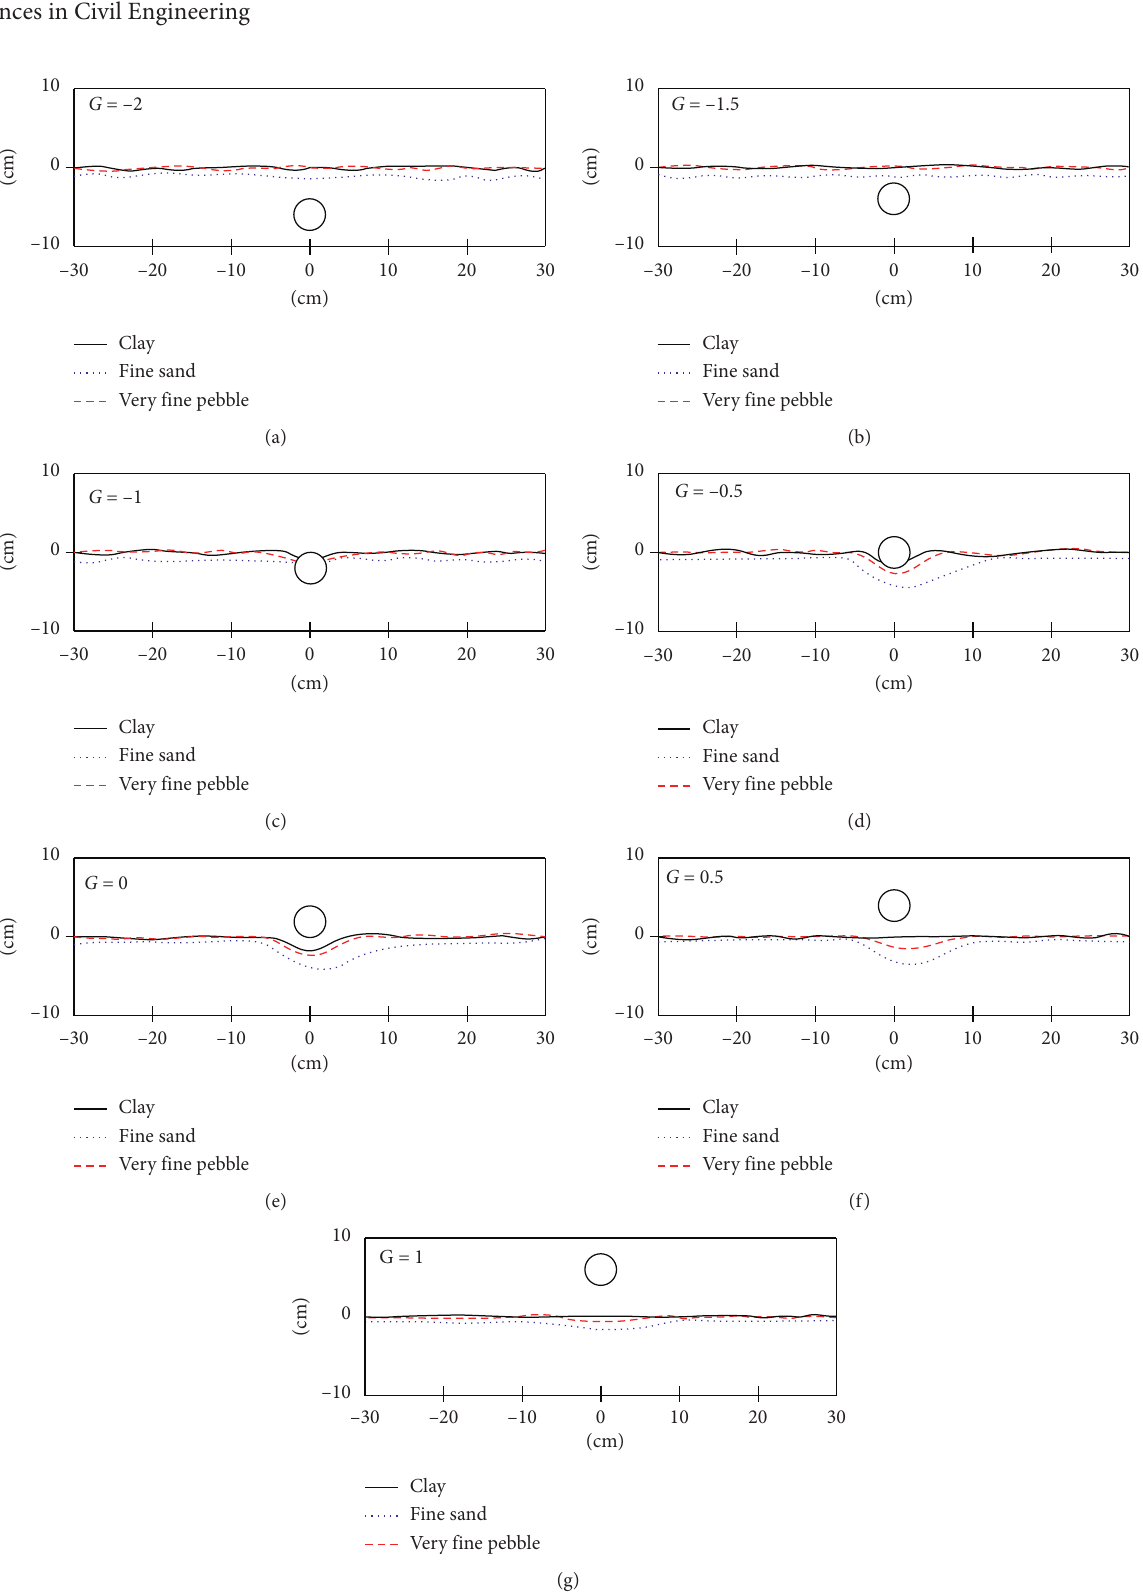
Figure 9: Scour profile under different embedment ratios: (a) scour profile with a embedment ratio of − 2, (b) scour profile with a embedment ratio of − 1.5, (c) scour profile with a embedment ratio of − 1, (d) scour profile with a embedment ratio of − 0.5, (e) scour profile with a embedment ratio of 0, (f) scour profile with a embedment ratio of 0.5, and (g) scour profile with a embedment ratio of